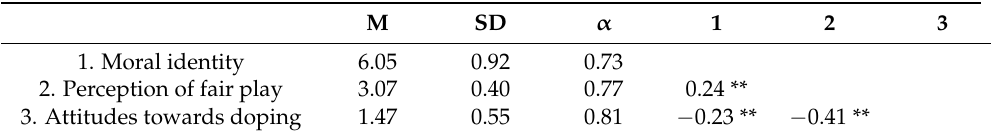
Table 1. Descriptive statistics and